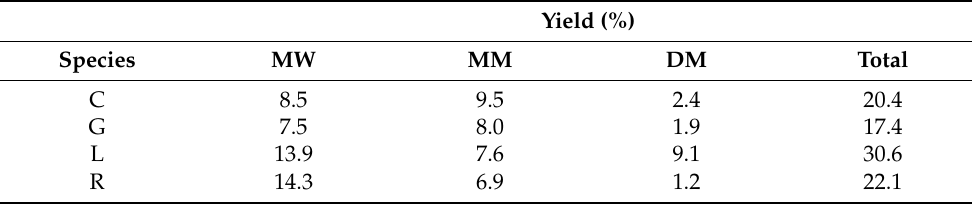
Table 1. Yield of microextracts from Hypericum species from the Canary Islands.